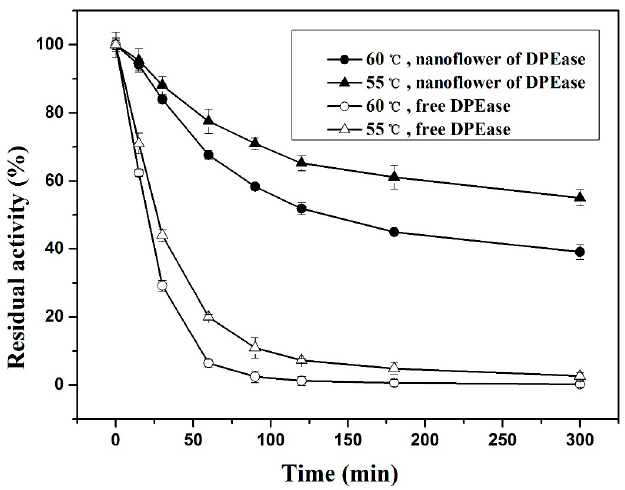
Figure 4. Thermal stability of nanoflower and free DPEase. The residual activities were determined at different given time intervals. The enzyme activities of the nanoflower (36.2 U/mg at 60 °C and 35.4 U/mg at 55 °C) and free DPEase (5.0 U/mg at 60 °C and 4.6 U/mg at 55 °C) were both 100%.